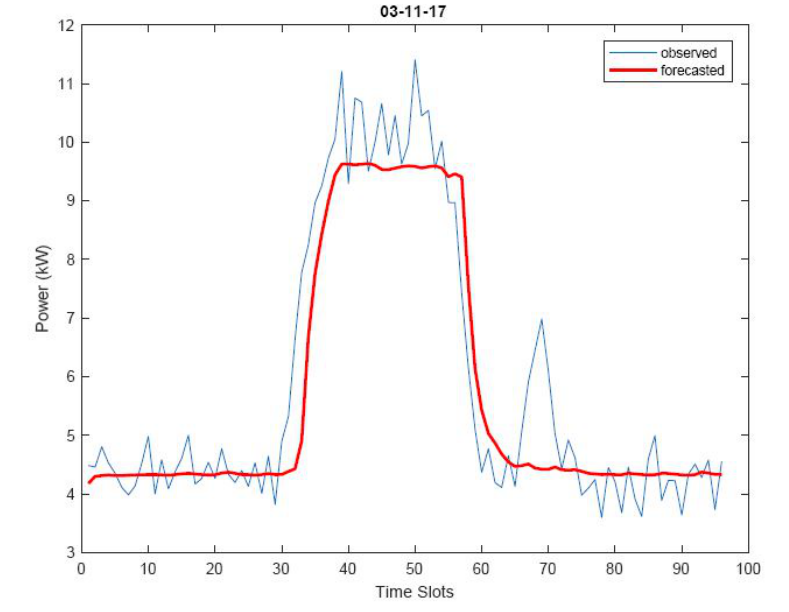
Figure 11. Pilot system: Municipal office (Monopoli), Day: 2 November 2017. Daily forecasts vs. observed power consumption.